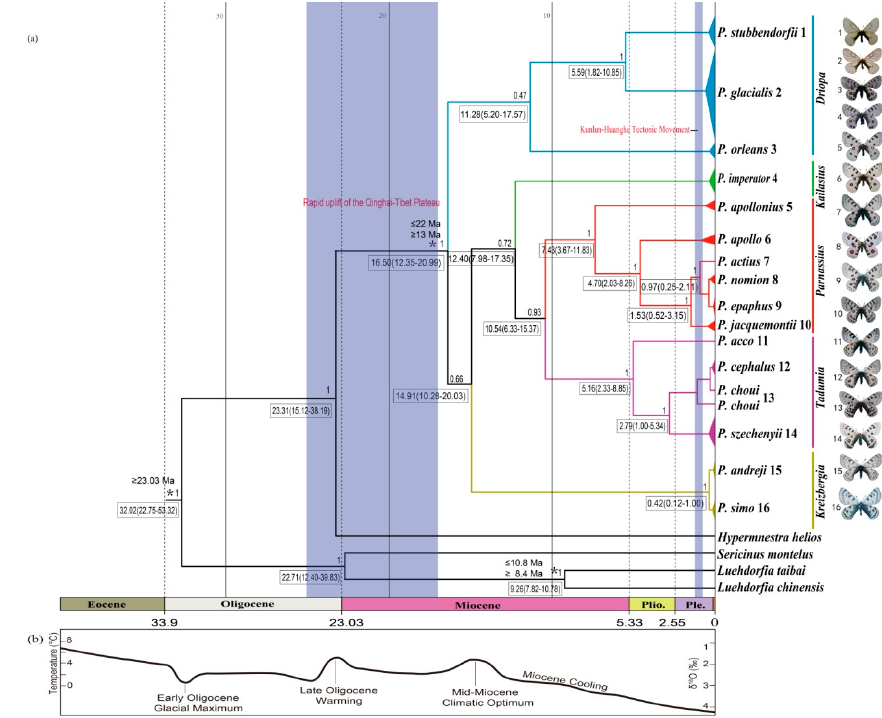
Figure 2. Estimated time tree of Parnassius based on mitochondrial sequences in relation to geological and climatic events from the Oligocene epoch to the present. ( a ) Divergence time estimated from BEAST analysis, with relevant geological events (blue shades), 95% highest posterior density (HPD) intervals (boxes) and calibration points (*). Numbers above branches represent Bayesian posterior probability (PP); ( b ) global climate curve, from Zachos et al.